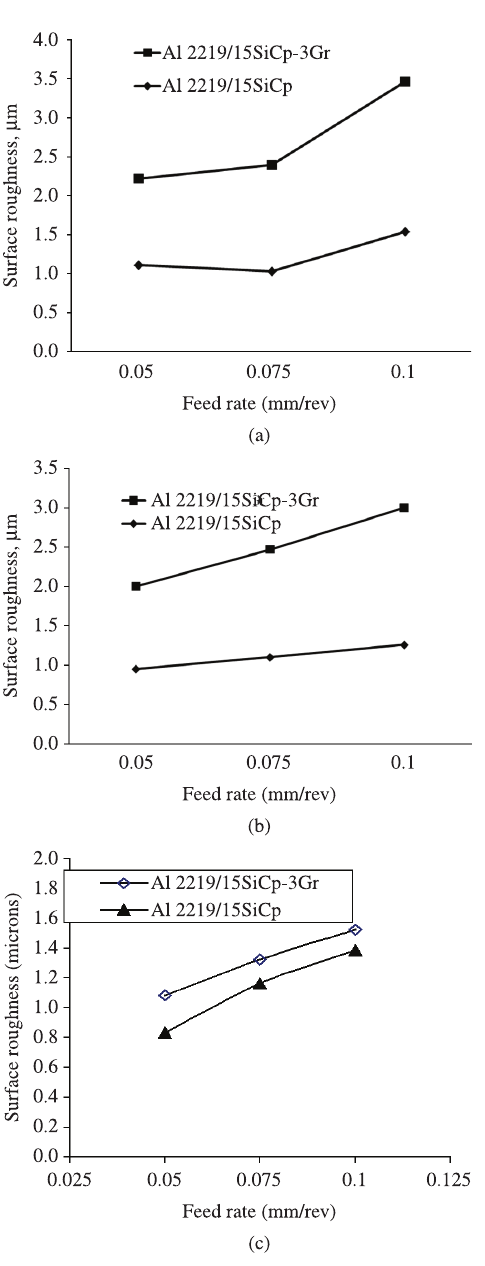
Figure 3. Variation of surface roughness (Ra) with depth of cut for both the composites at a constant length of cutting of 50 mm, cutting speed of 80 m/min, feed rate of 0.075 mm/rev for (a) carbide tool (b) Coated Carbide tool and (c)PCD